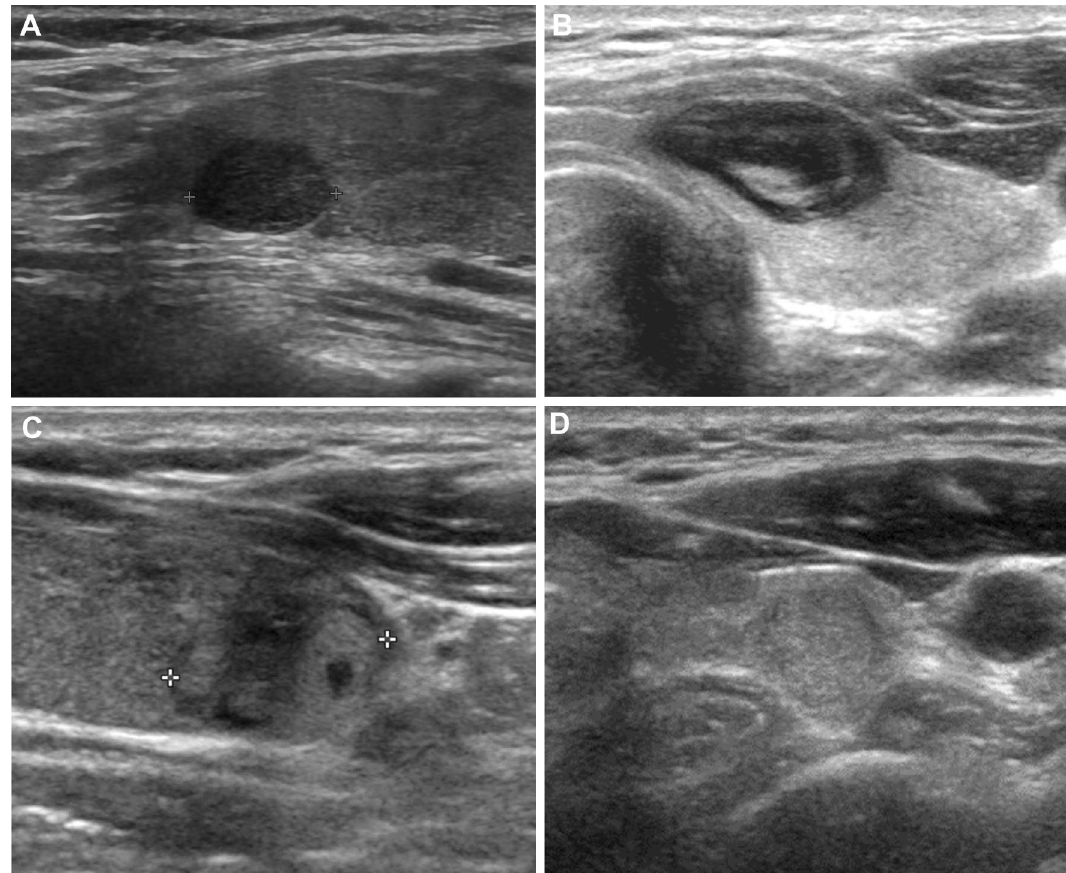
Figure 2. Thyroid nodules classified according to the echotexture and echogenicity. ( A ) A nodule with homogeneous hypoechogenicity. Diagnosis: Conventional papillary thyroid carcinoma ( B ) A nodule with heterogeneous, predominant hypoechogenicity. Note internal iso- or hyperechoic solid portions consisting less than 50% of the nodule. Diagnosis: Conventional papillary thyroid carcinoma. ( C ) Nodule with heterogeneous, predominant iso- or hyperechogenicity. The hypoechoic solid portion accounts for less than 50% of the nodule. Diagnosis: Benign follicular nodule in core needle biopsy. D. Nodule with homogeneous iso- or hyperechogenicity. Diagnosis: Benign follicular nodule in core needle